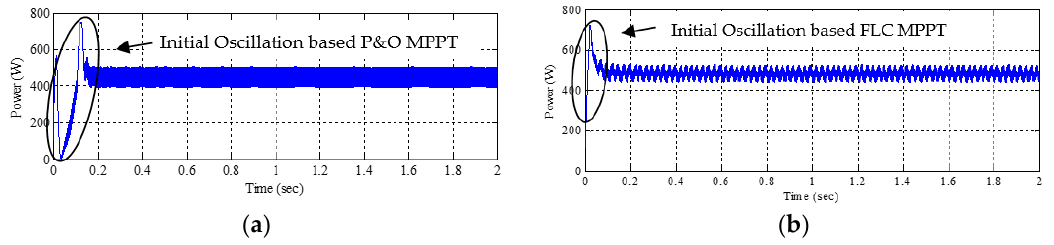
Figure 11. Comparison of output power obtained using ( a ) P&O MPPT and ( b ) FLC MPPT methods for PV panel 1 without boost converter.